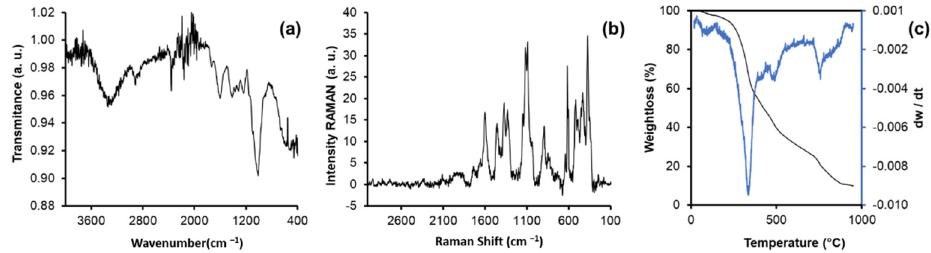
Figure 4. ( a ) FTIR spectrum (black line), ( b ) RAMAN spectrum (black line), and ( c ) Thermogravi- metric analysis of biosorbent prepared from agave bagasse. DTG (blue line) and TGA (black line). Figure 4b shows the RAMAN spectrum of the agave fiber after baseline correction and area normalization. Each of the bands was studied in detail and compared with information previously reported in the literature. The bands at 2945, 1658, 1620, 1601, 1423, 1330, 1270, 1130, 786, 730, 634, 595, and 560 cm −1 can be attributed to the different stretching, bending, deformation, and torsion vibrations of the bonds related to lignin, whilehile the bands centered at 2897, 1480, 1465, 1378, 1121, 1098, 1037, 896, 520, 458, 435, and 378 cm −1 , can be attributed to the different vibrations of the cellulose and hemicellulose structure [7].